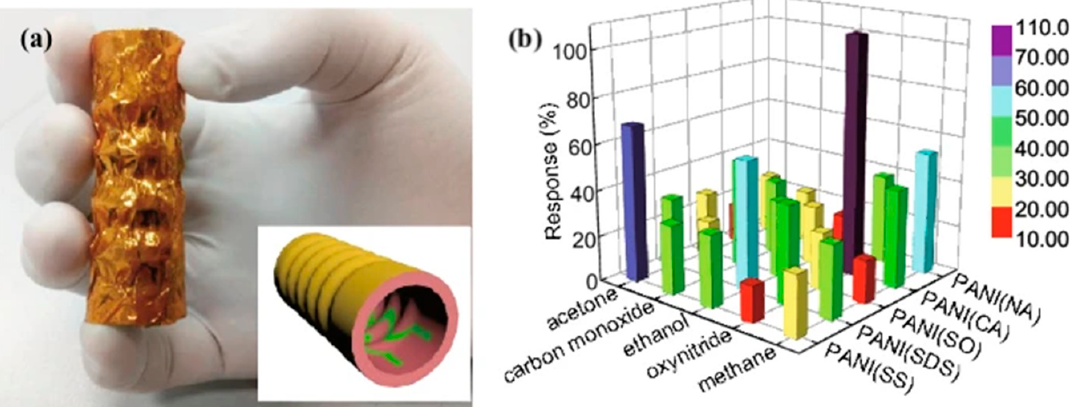
Figure 8. ( a ) PANI/PVDF bellow; ( b ) The response of the five sensing units to 600 ppm gases at room temperature